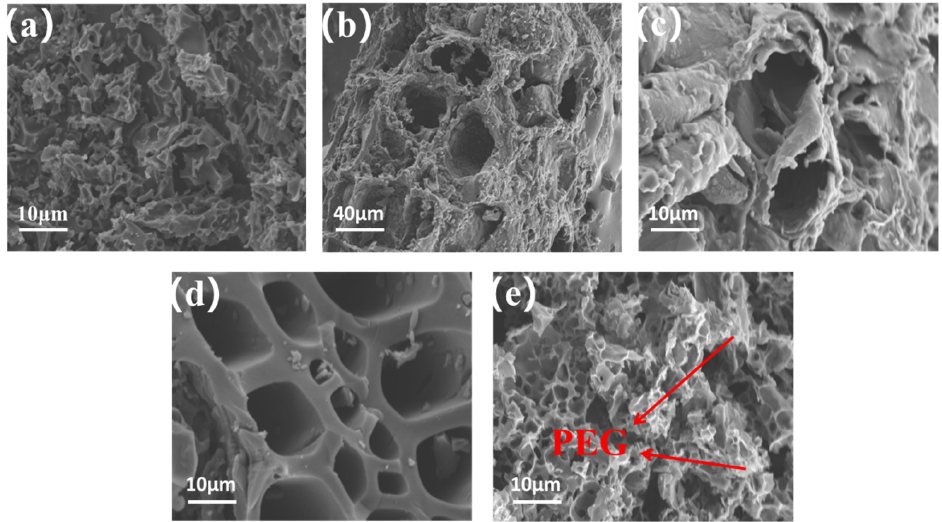
Figure 4. ( a – c ) SEM pictures of 8CK, 8CP, and 8CH; ( d ) a sectional SEM diagram of 8CP; ( e ) SEM photos of 8CPK.